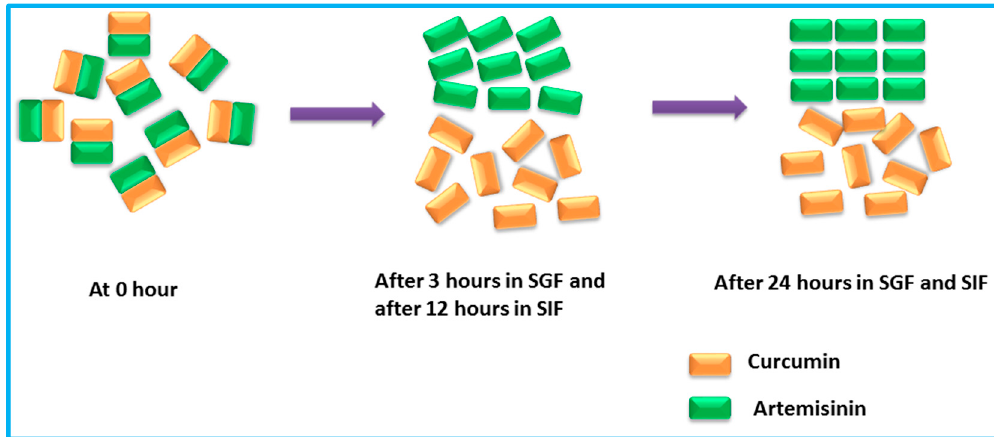
Scheme 2. Pictorial representation of CUR-ART physical stability in simulated fluids.